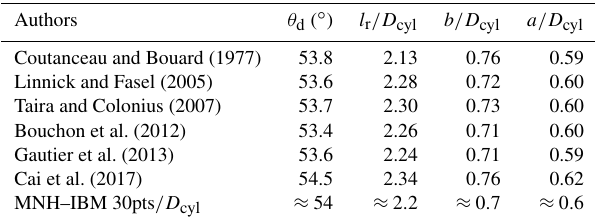
Table 1. Description of the standing eddies in the wake of the solid cylinder ( Re = 40): comparison of the separation angle θ d ( ◦ ), re- circulating length l r (m) and vortex core location (a ; b) between the literature and